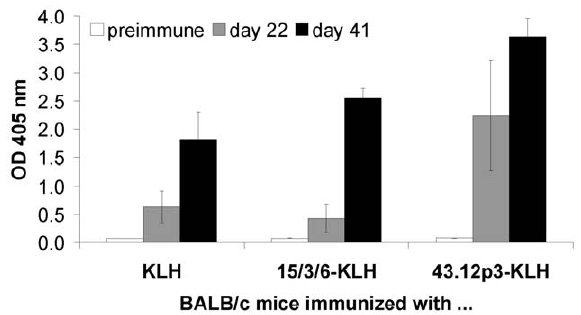
Figure 4. Antigen-specific immune response of immunized BALB/c mice. Serum samples from day 0 (preimmune serum; white bars), day 22 (grey bars), and day 41 (black bars) were tested in ELISA. The mean value of the individual responses of each group is shown and standard deviations are indicated by error bars. Peptide specificity of sera from mice either immunized with 15/3/6- or 43.12p3-KLH conjugate was assessed using the respective peptide-BSA conjugates. Sera from KLH immunized mice were tested for specificity to KLH.